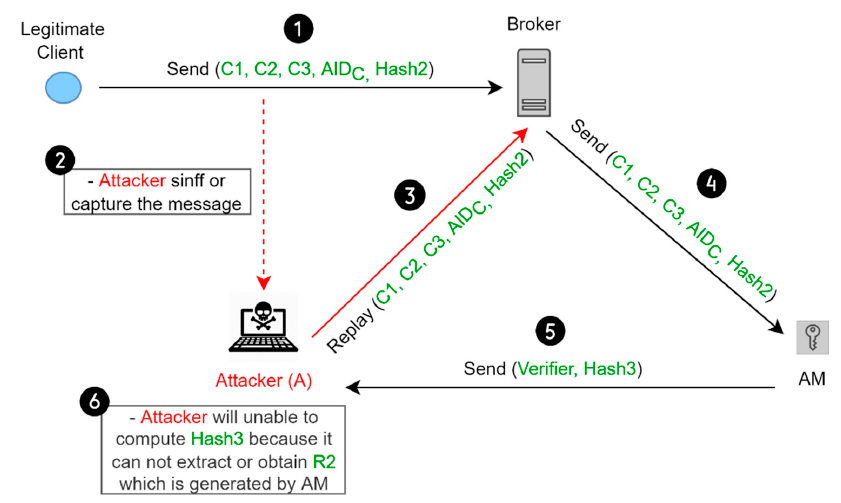
Figure 10. Replay